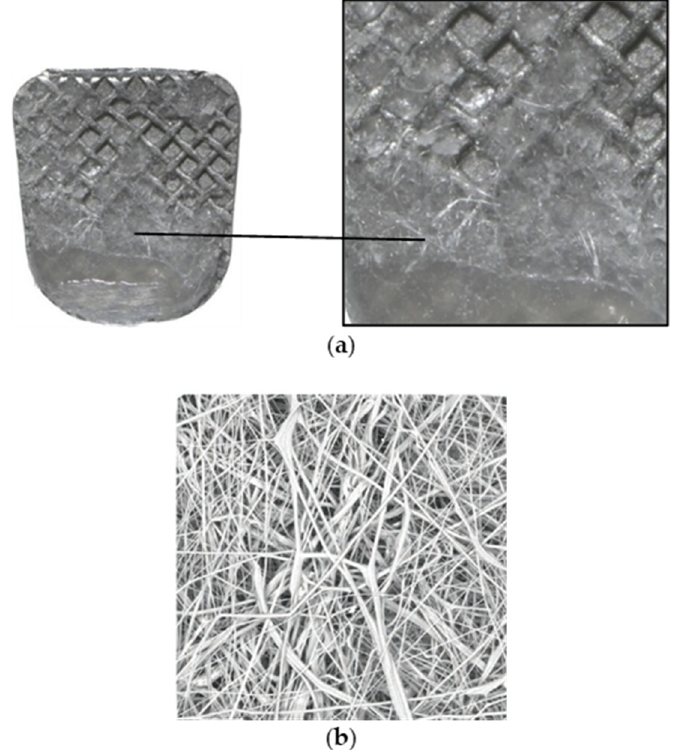
Figure 2. ( a ) Images of APC TM Flash-Free adhesive remnant from 10× magnification light microscope digital camera. ( b ) The non-woven polypropylene fibers used in the APC TM Flash-Free adhesive consist of randomly oriented, entangled fibers (3M TM APC TM Flash-Free Adhesive, Technical Over- view).